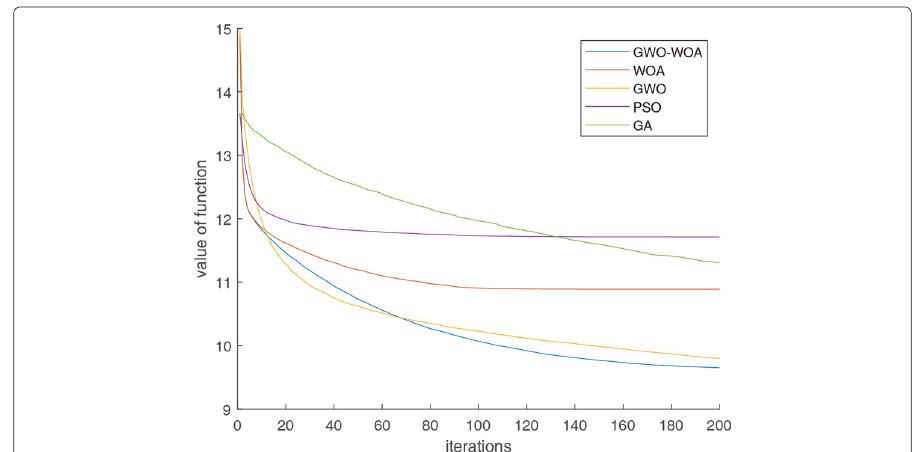
Fig. 3 Convergence curve of algorithms when device number is 90